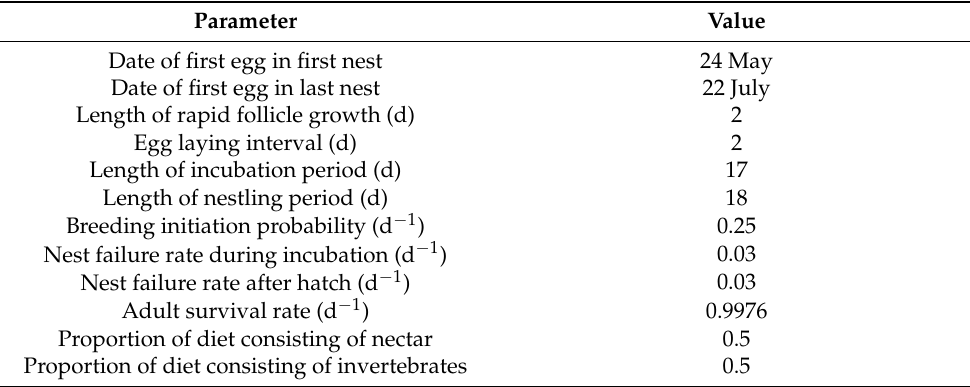
Table 1. MCnest life history parameters for ruby-throated Hummingbird.